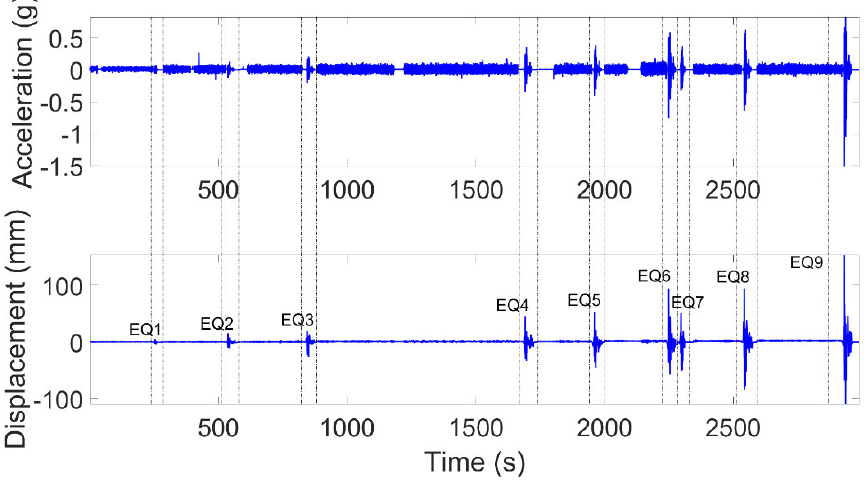
damage and values of engineering demand parameters (e.g., residual and transient peak drift ratios) taken from [31]. The reader is referred to [32–34] for further details on the tests.